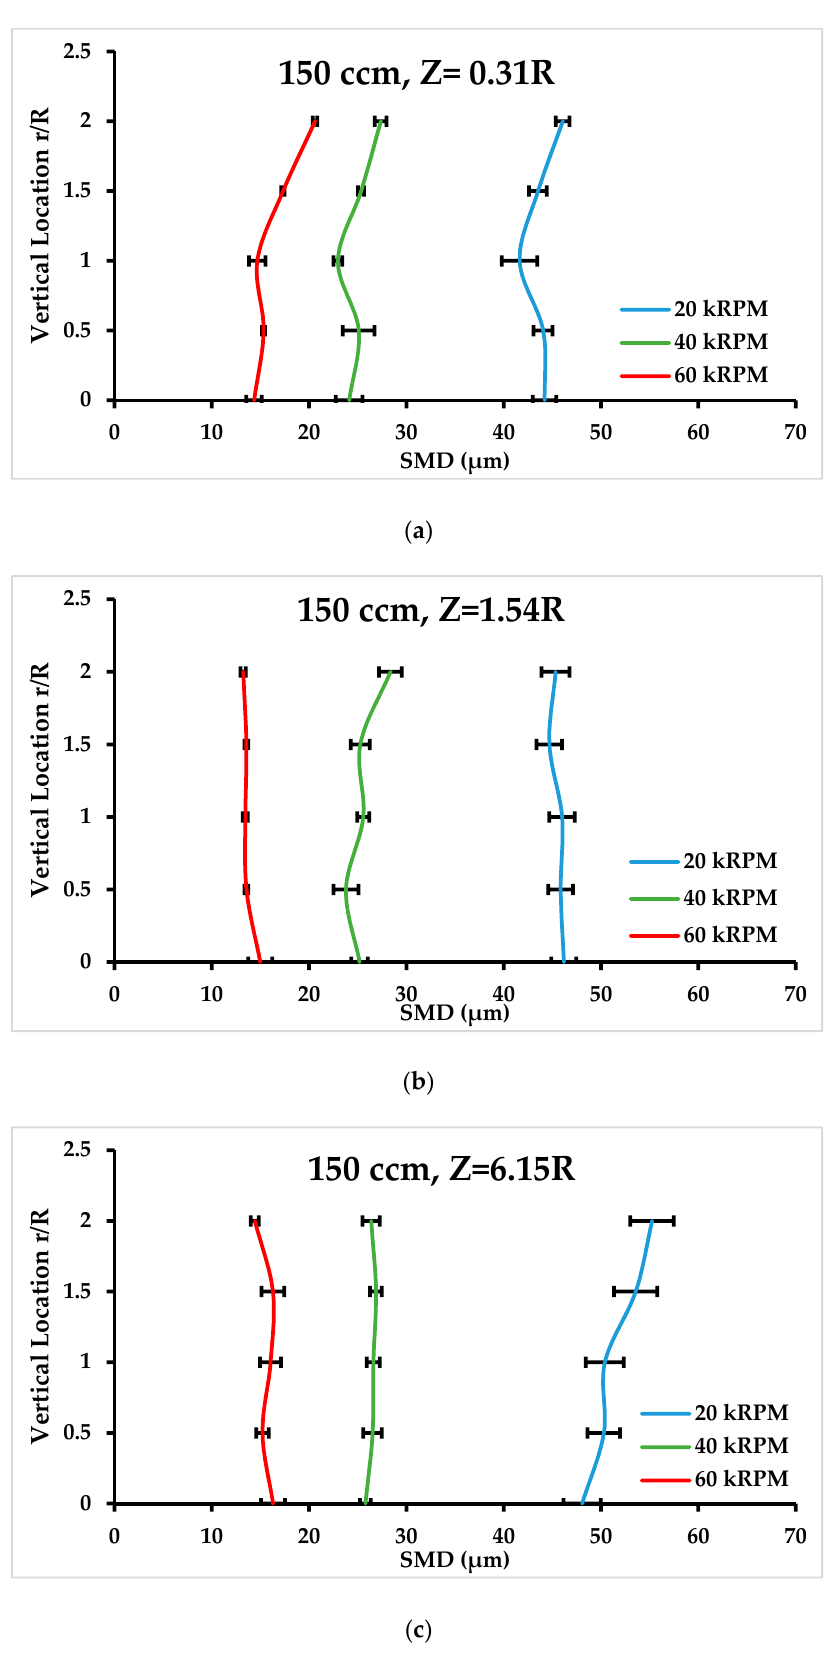
Figure 6. The sauter mean diameter, SMD (D 32 ) plotted at the normalized vertical locations from the central (lateral) axis of the spray flow field, at different rotational speeds for a fixed fluid flow rate of 150 ccm.